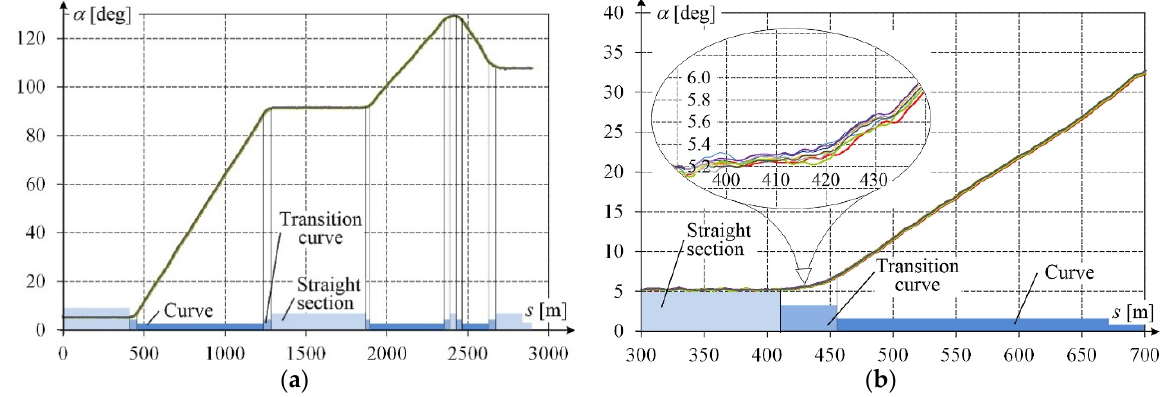
Figure 9. Railway track direction angle obtained from multiple passages: ( a ) entire curve; ( b ) frag- ment in an expanded scale.